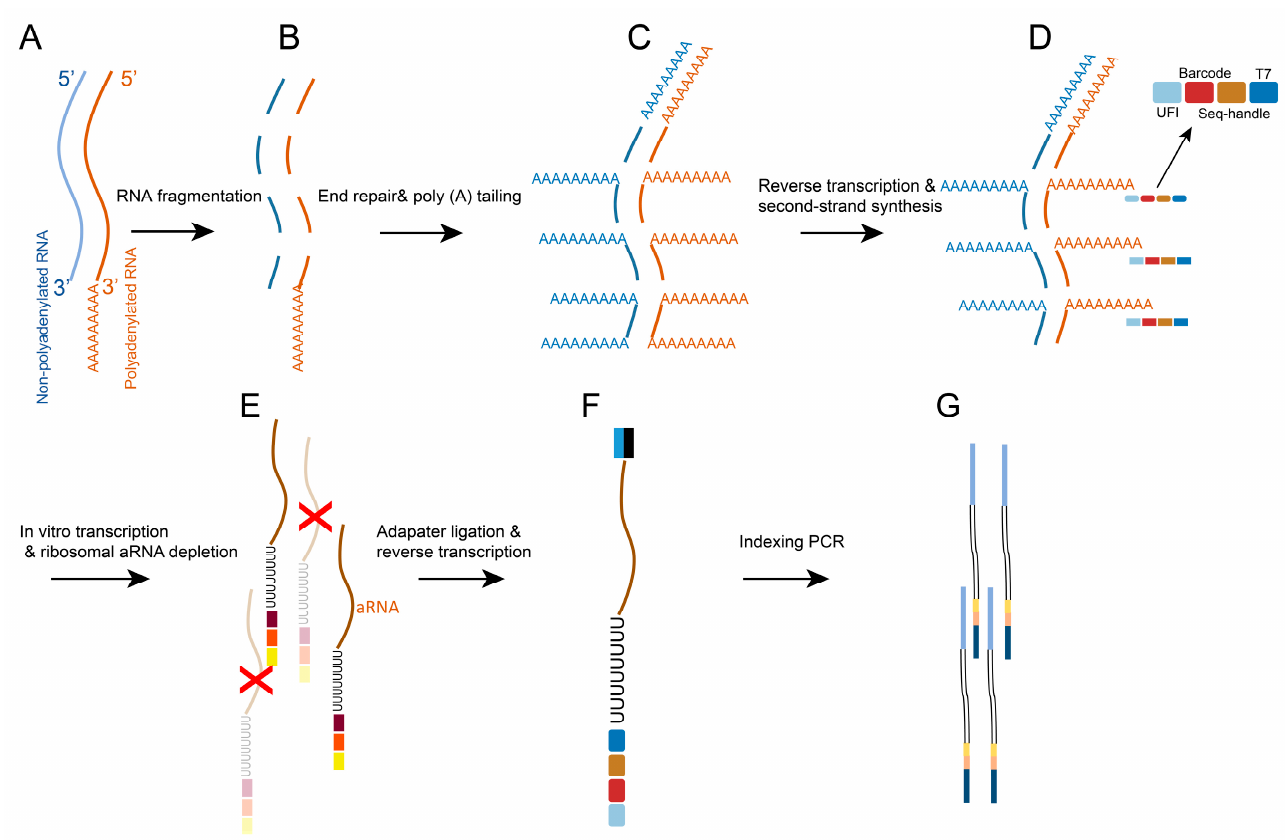
Figure 2. Overview of the VASA-seq workflow. ( A ) Collection of RNA in single cells. ( B ) Fragmentation process of RNA fragments. ( C ) Repair of RNA fragments and polyadenylation. ( D ) Reverse transcription of mRNA and completion of cDNA synthesis ( E ) In vitro transcription process. ( F ) Adaptation of aptamer Ligation and reverse transcription processes. ( G ) Indexing PCR.